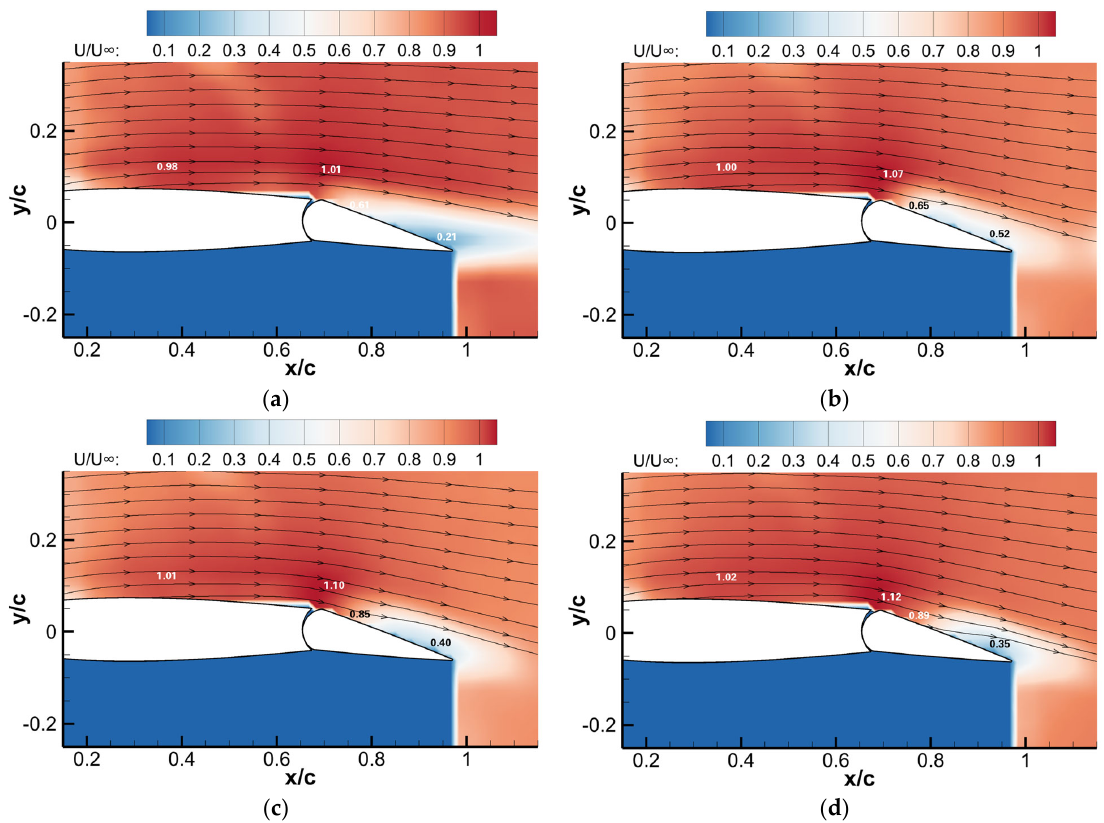
Figure 14. Velocity cloud diagram and streamline diagram of vertical tail upper surface under different momentum coefficient controls: ( a ) C µ = 0; ( b ) C µ = 0.083%; ( c ) C µ = 0.166%; ( d ) C µ = 0.332% ( β = 0°, δ = 15°, Re = 2.12 × 10 5 ).